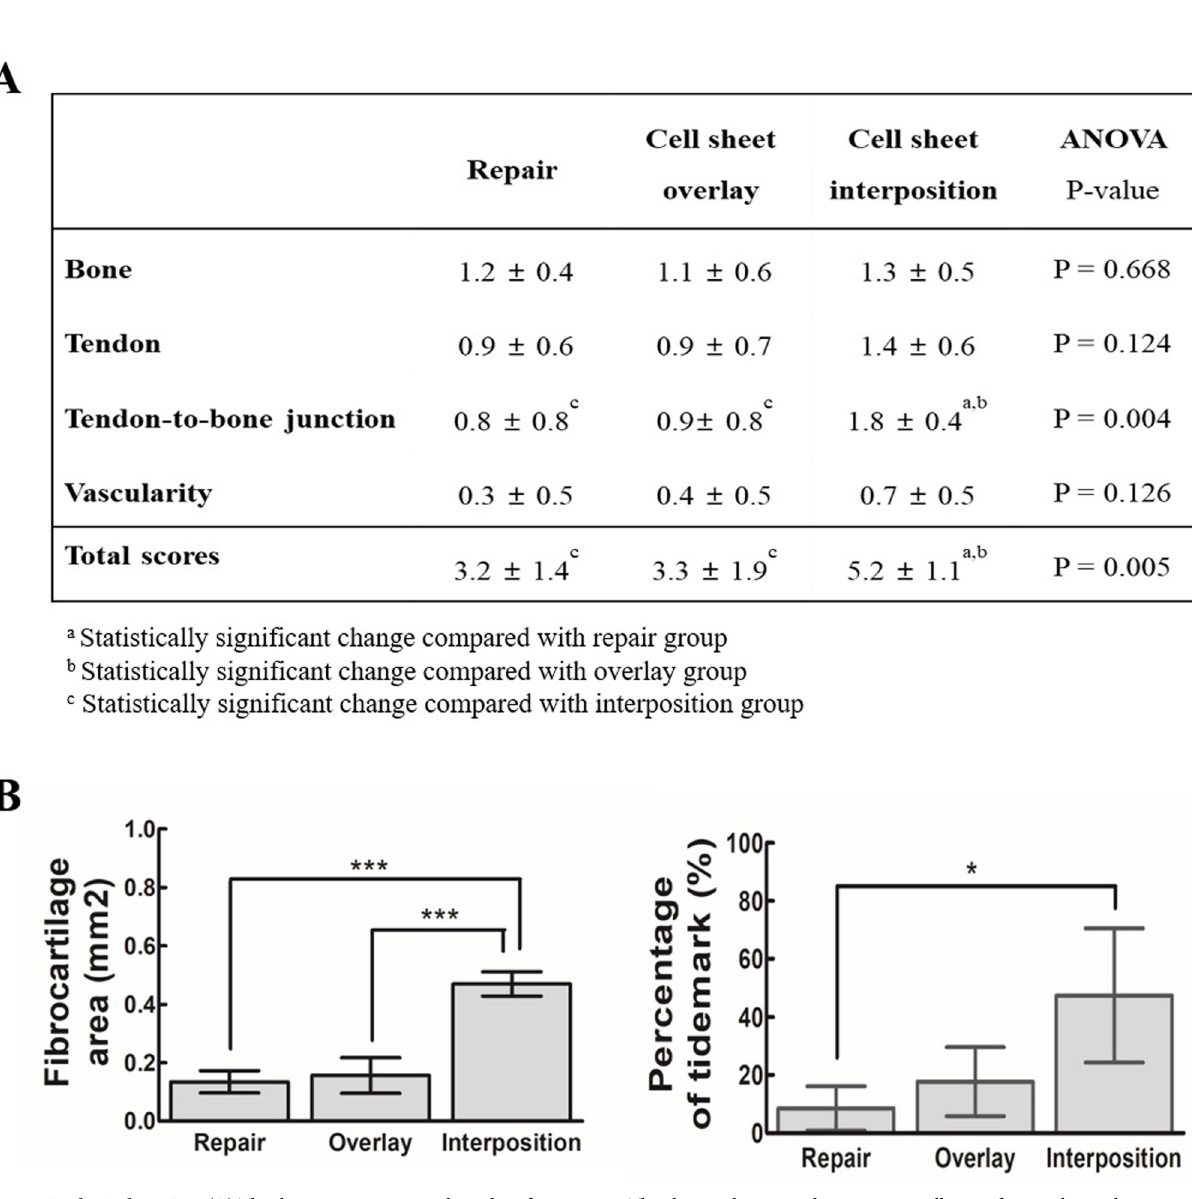
Fig 6. Histological scoring. (A) The three groups were evaluated on four criteria. The above subscript indicates statistically significant relationships between groups. (B) Graph quantifying (left) the relative fibrocartilage formation and (right) percentages of the produced tidemark length relative to the fibrocartilage width at the tendon-to-bone junction. Error bars represent standard deviation. � P < 0.05, ��� P < 0.001 (n = 4).